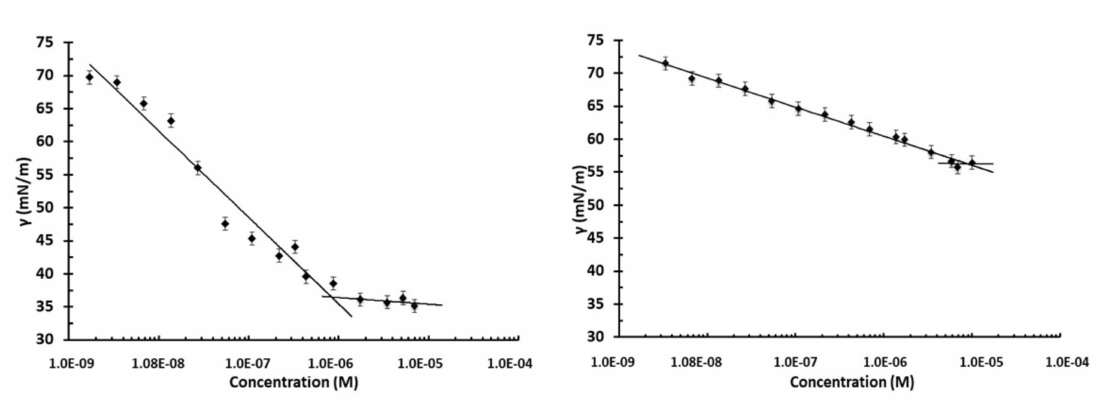
Figure 4. Surface tension of Th CP (left) and At CP (right) in 10 mM phosphate bu ff er pH 7, as a function of protein